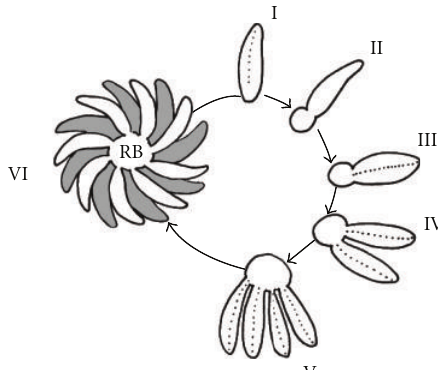
Figure 9: Formation of RB through of the endodiogeny